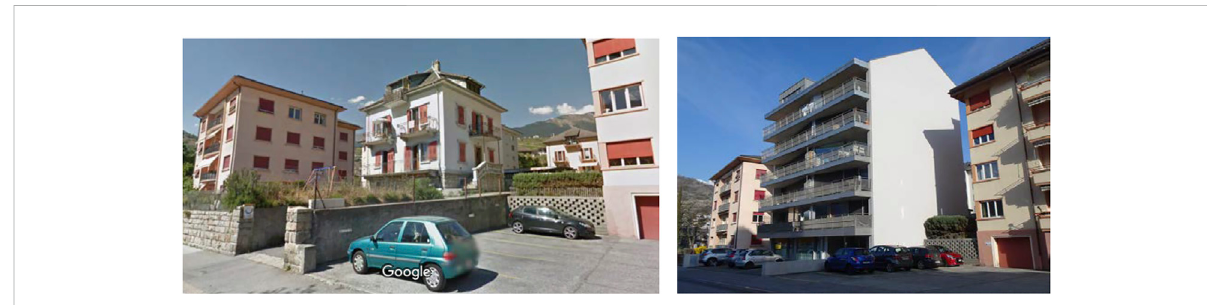
FIGURE 7 Sion, low-rise URM building demolished and replaced by a mid-rise RC building.